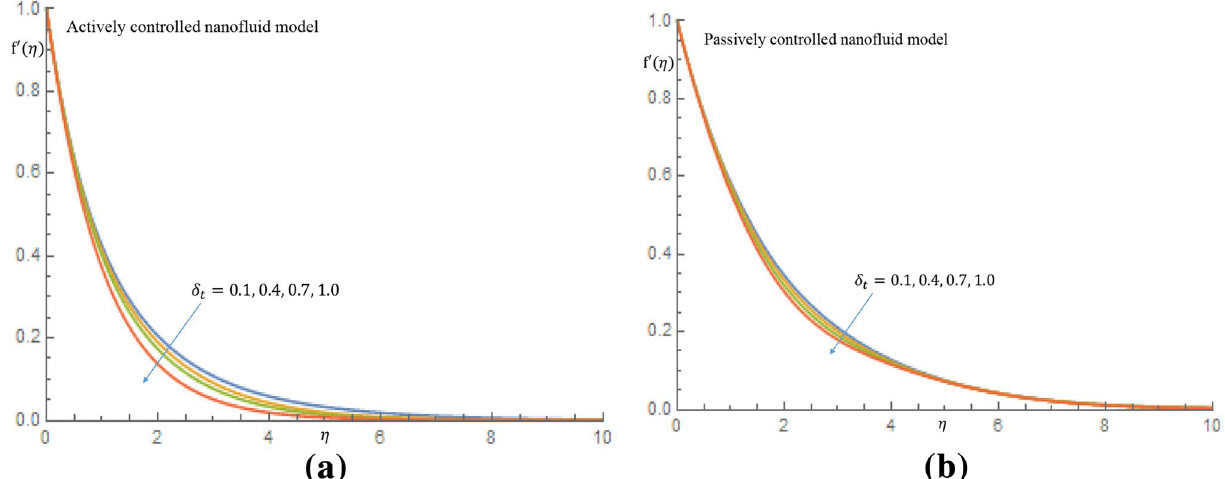
Figure 7. ( a ) Effect of δ t on velocity profile when K 1 = K 2 = 0 . ( b ) Effect of δ t on velocity profile when K 1 = K 2 = 0 .